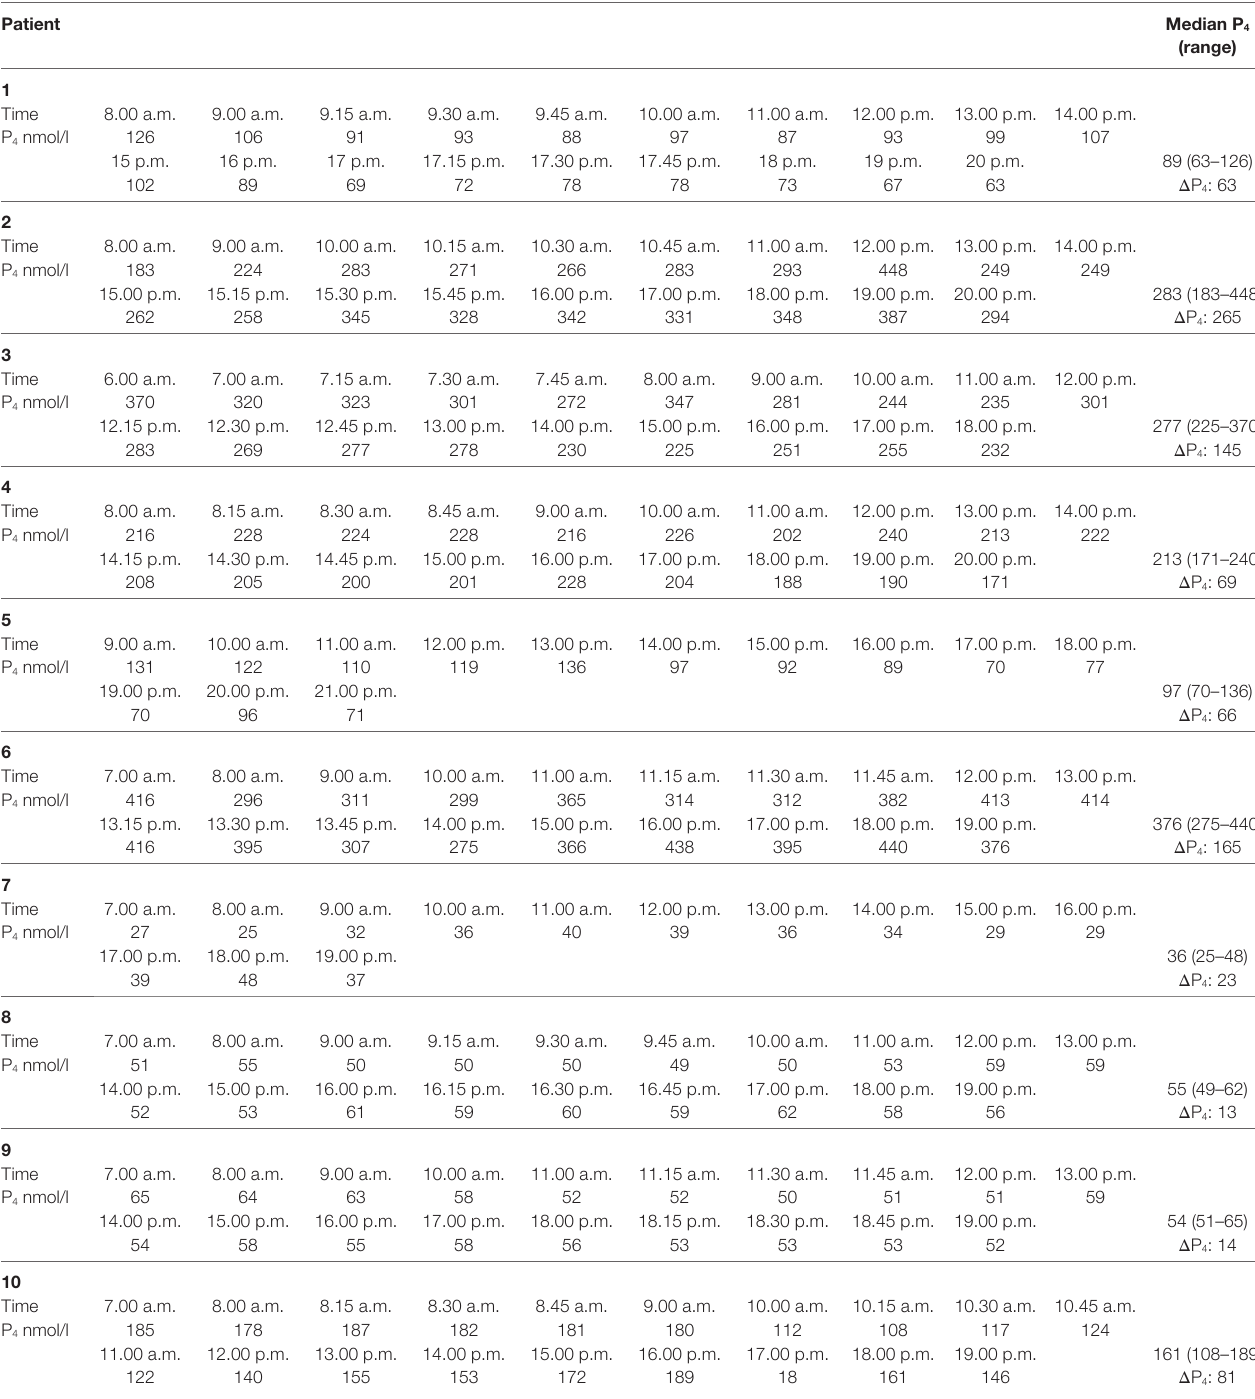
Table 2 | Mid-luteal serum progesterone concentrations during daytime in 10 women undergoing in vitro fertilization treatment. Patient Median P 4